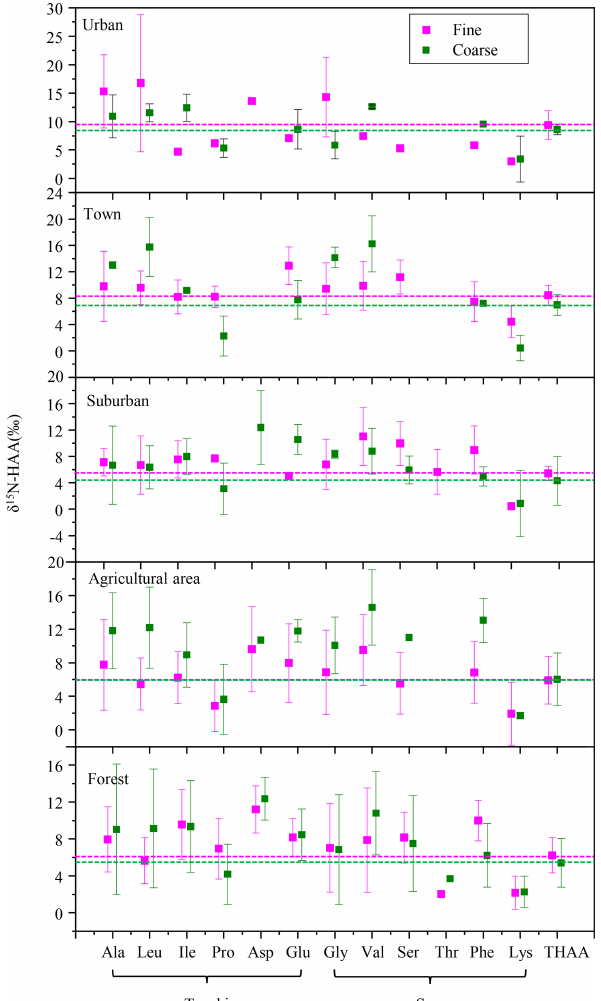
Figure 8. δ 15 N-HAA patterns of fine and coarse aerosol particles in urban, town, suburban, agricultural and forest